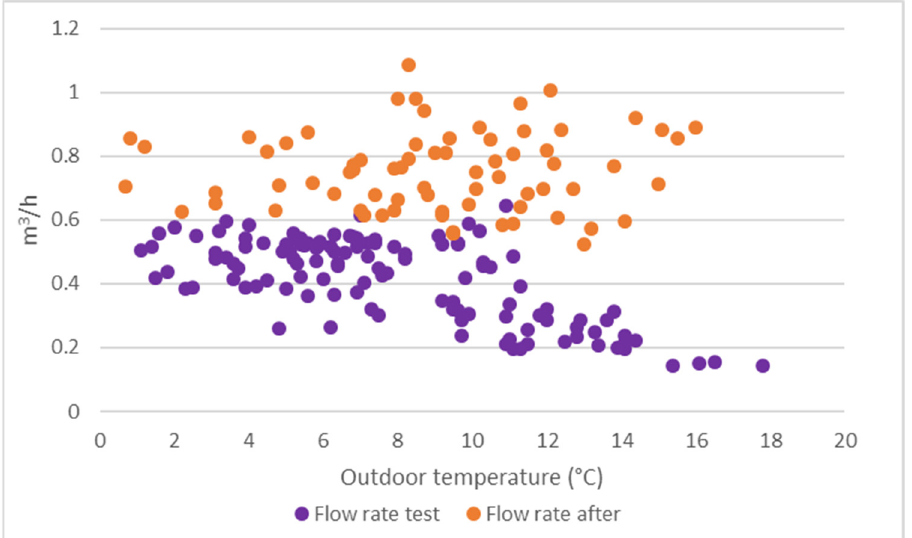
Figure 8. Comparison of the measured hourly average flow rates in the space heating system during the test and in the reference period afterward.